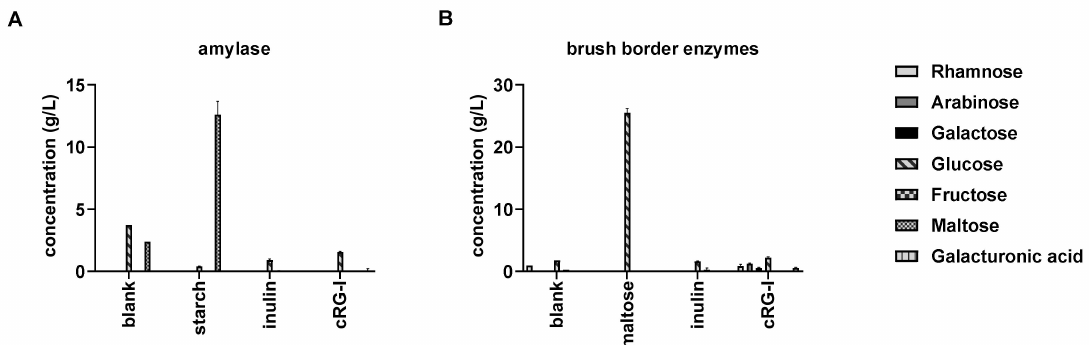
Figure 2. Digestion of cRG-I (carrot-derived rhamnogalacturonan-I) by amylase ( A ) and brush border enzymes ( B ) versus inulin, cooked starch, and maltose. Blank incubations containing all reagents in absence of a substrate were included. Average ( ± st. dev.) concentrations of di ff erent monosaccharides and maltose were measured by High Performance Anion Exchange Chromatography (HPAEC) ( n = 3).